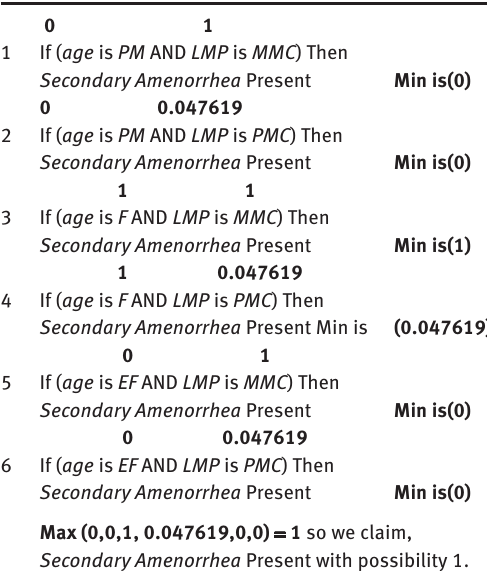
Table 3: Fuzzy Rules Applied to Patient P